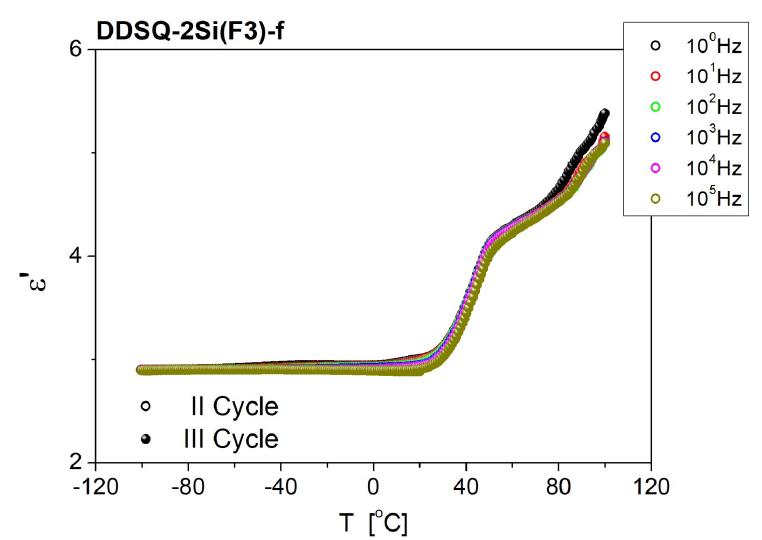
Figure 10. Temperature dependence of dielectric permittivity, measured for a thin film of DDSQ- 2Si(F3)-f. II cycle—sample was cooled from RT to T = − 100 °C; III cycle—sample heated from − 100 °C to 100 °C.